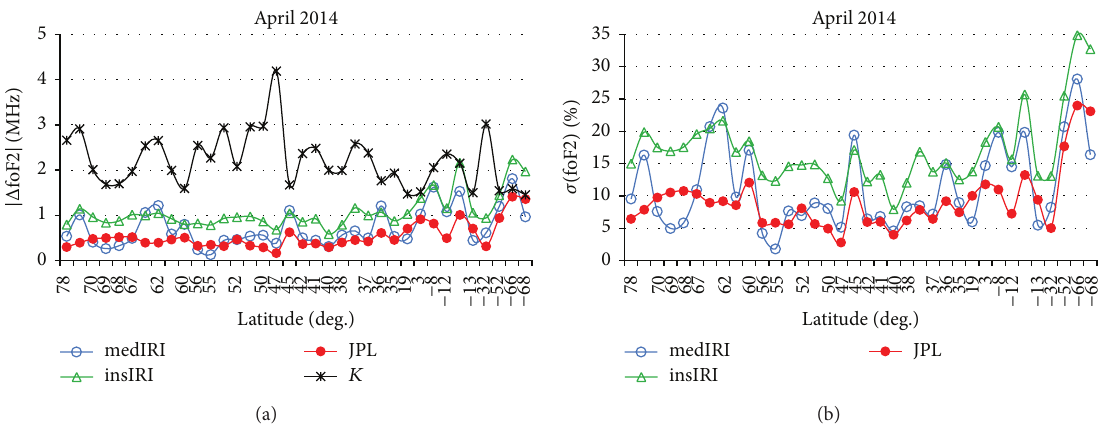
Figure 3: The latitudinal dependence of average absolute (a) and standard (b) deviations of the median and instantaneous values correspond- ing to the IRI model and global map JPL. The coefficient 𝐾 shows efficiency of 𝜏 (med).